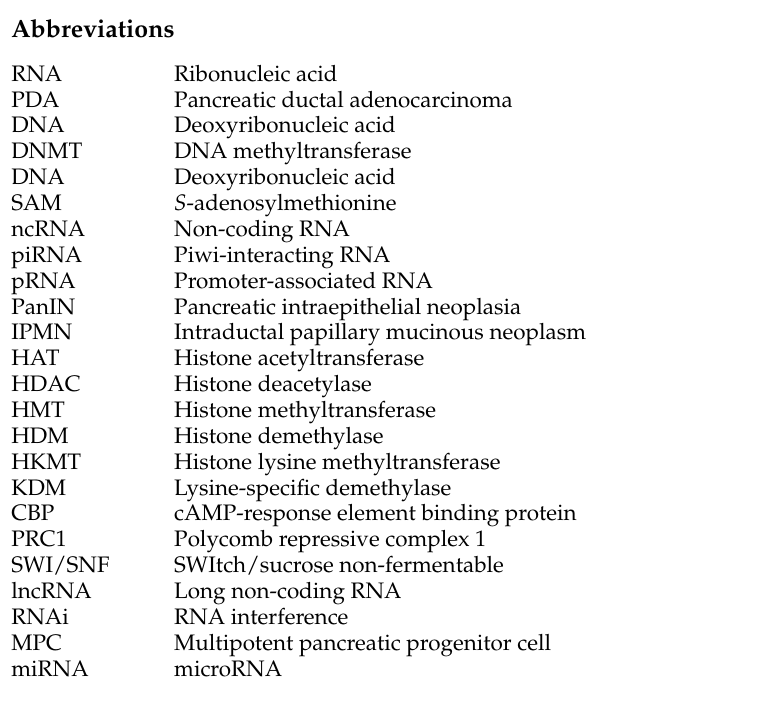
Acknowledgments: This study was supported by Global REACH Partnership Development Grant from University of